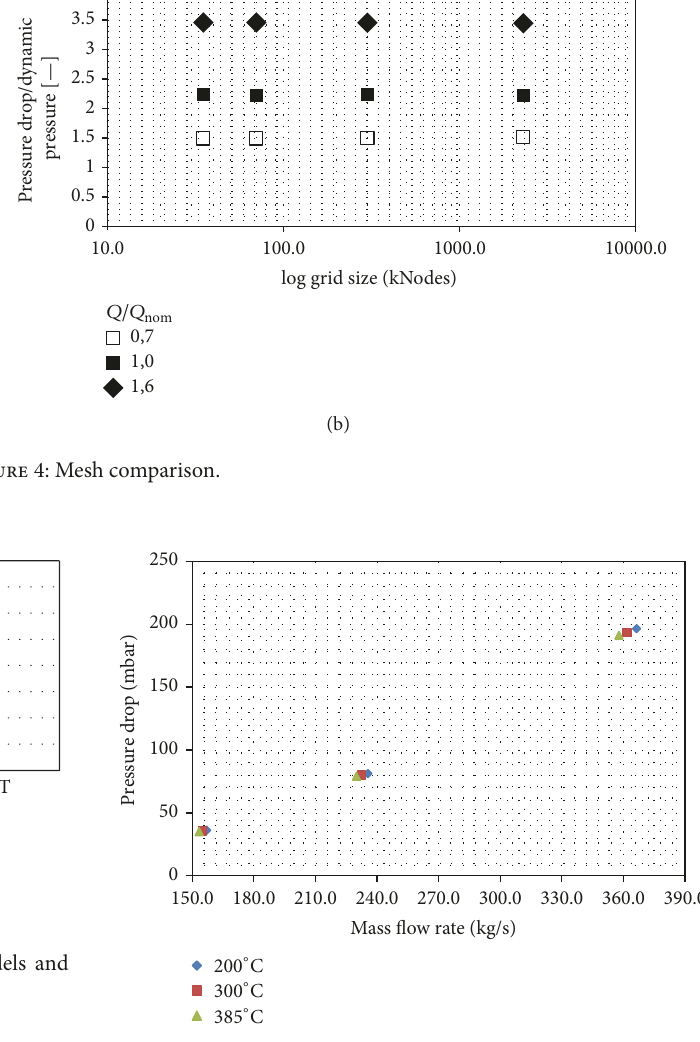
Figure 6: Comparison for different temperature values.